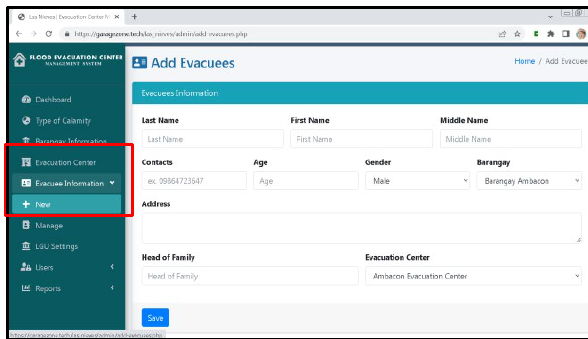
Figure 19. The Page where the Admin will add New Evacuee